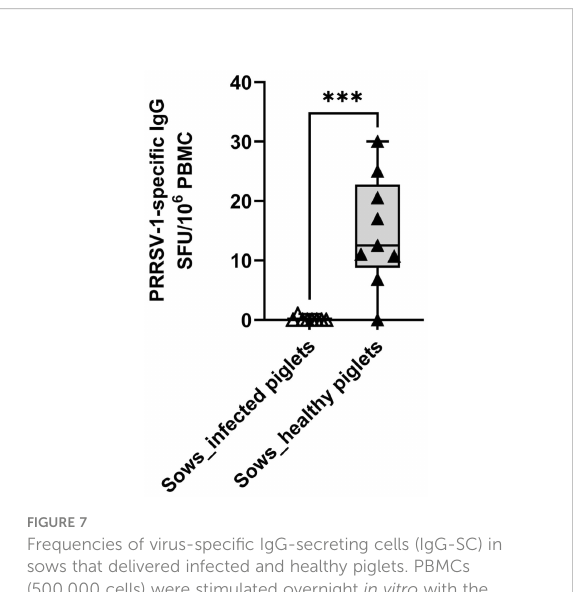
FIGURE 7 Frequencies of virus-speci fi c IgG-secreting cells (IgG-SC) in sows that delivered infected and healthy piglets. PBMCs (500,000 cells) were stimulated overnight in vitro with the circulating fi eld virus JA2 at MOI 0.1 followed by IgG ELISPOT development. Statistical signi fi cance was measured by the Mann – Whitney nonparametric test, *** p <